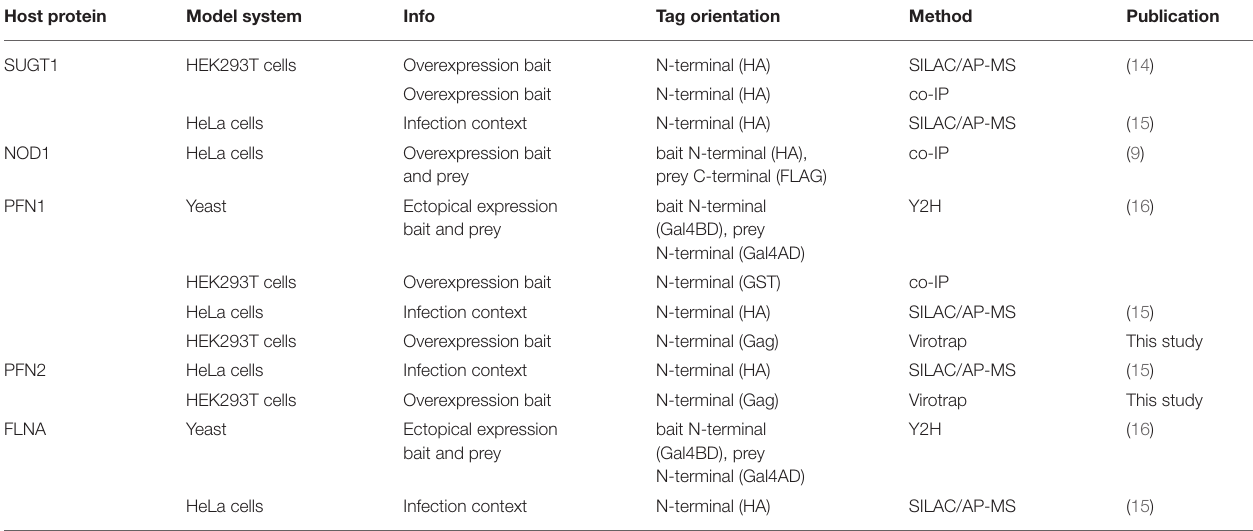
TABLE 1 | Overview of literature confirmed SspH2